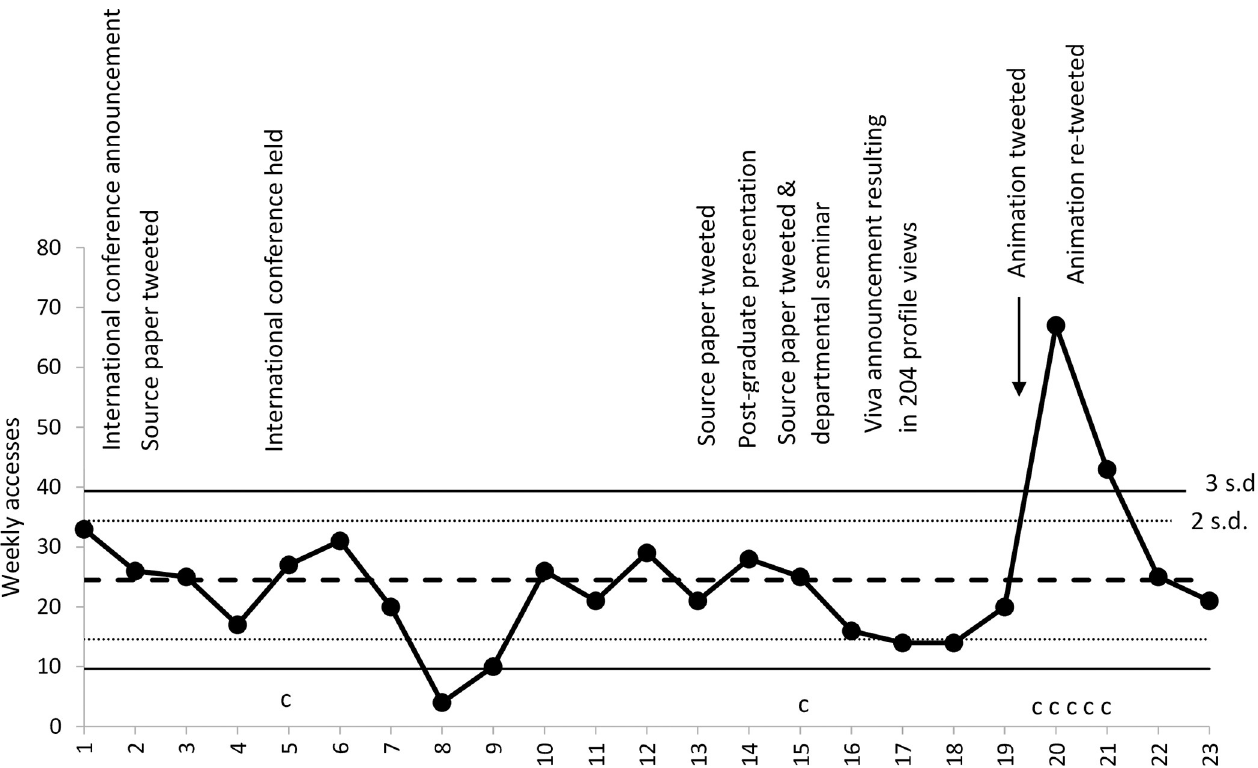
Fig 2. A statistical process control c-chart showing weekly accesses of Sykes et al. (2020) and numbers of contacts [c] made to first author by stakeholders [s. d. = Standard deviation].